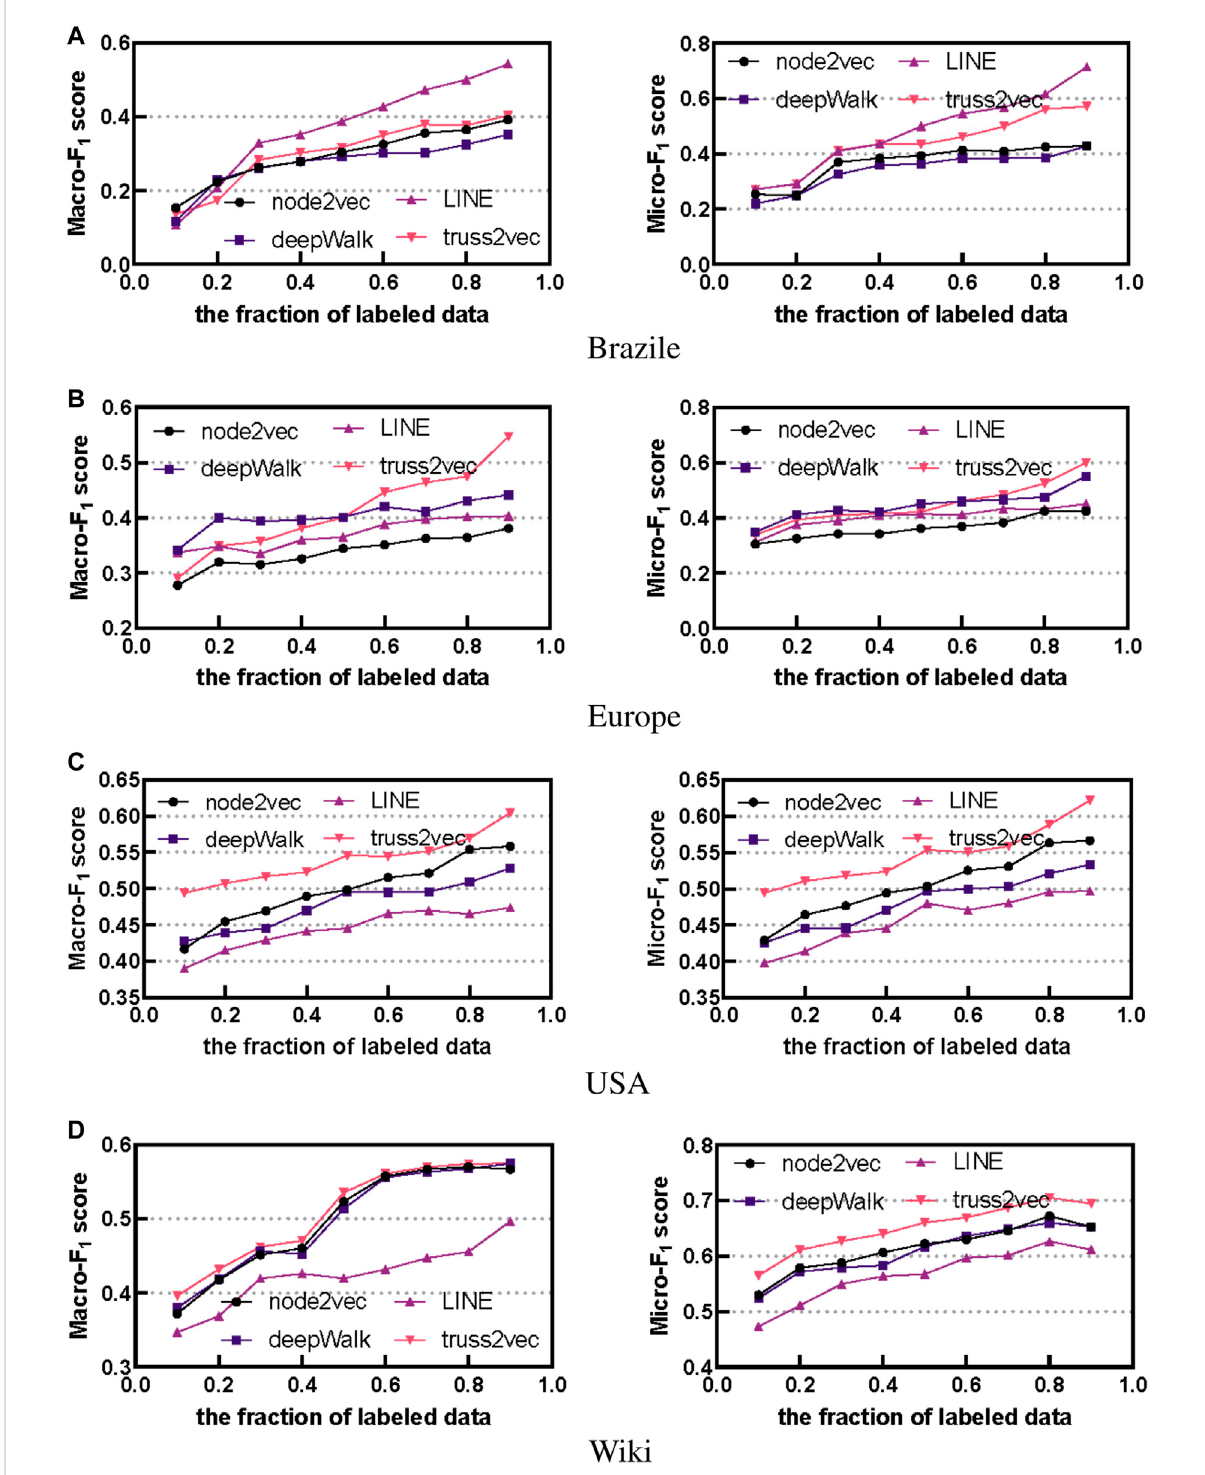
FIGURE 3 The results of multi-classi fi cation. We use different fraction of labeled data as the training set, showing the scores of 4